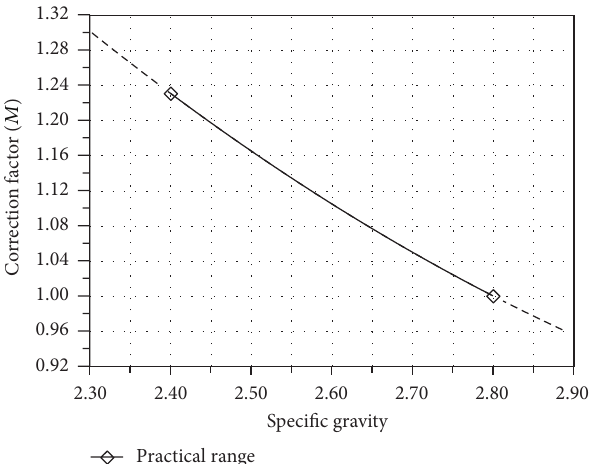
Figure 4: Relationship between specific gravity of coarse aggregate and the correction factor ( 𝑀 ).